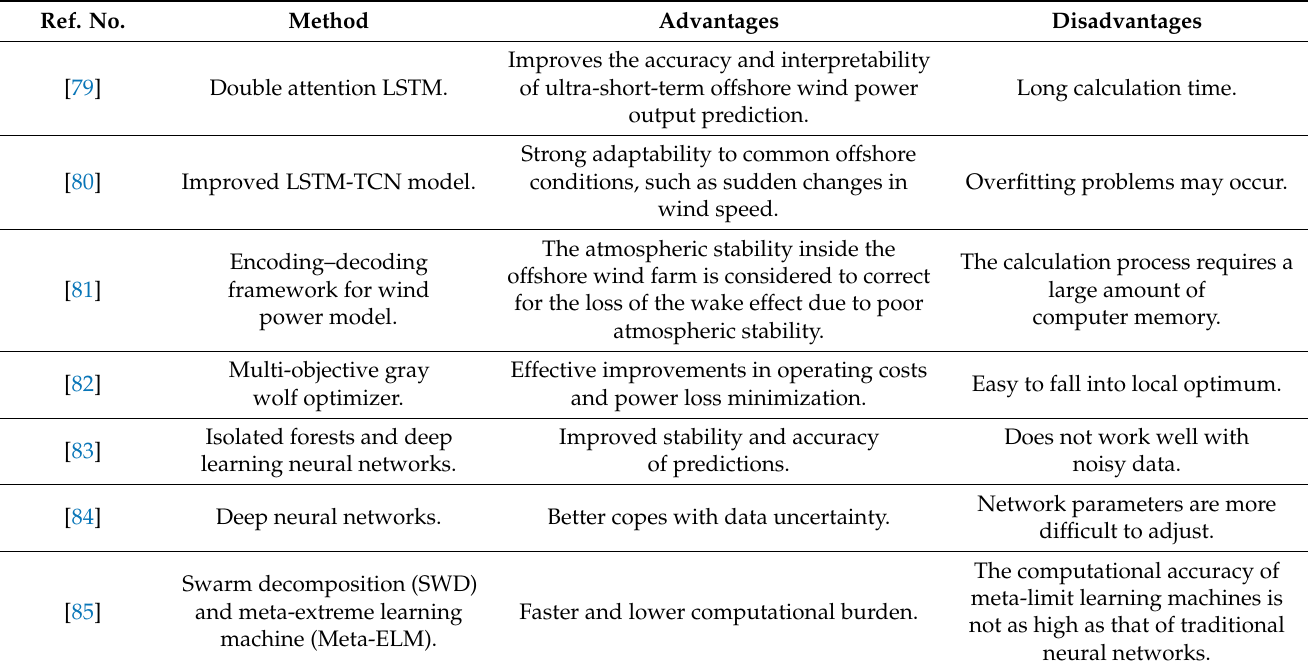
Table 4. Offshore wind power output prediction